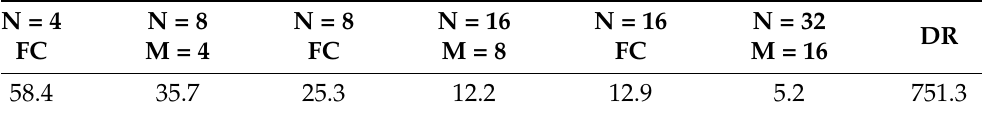
Table 1. Mean of Monte Carlo simulations’ position RMSE in each situation, using magnetic anomaly map (unit: